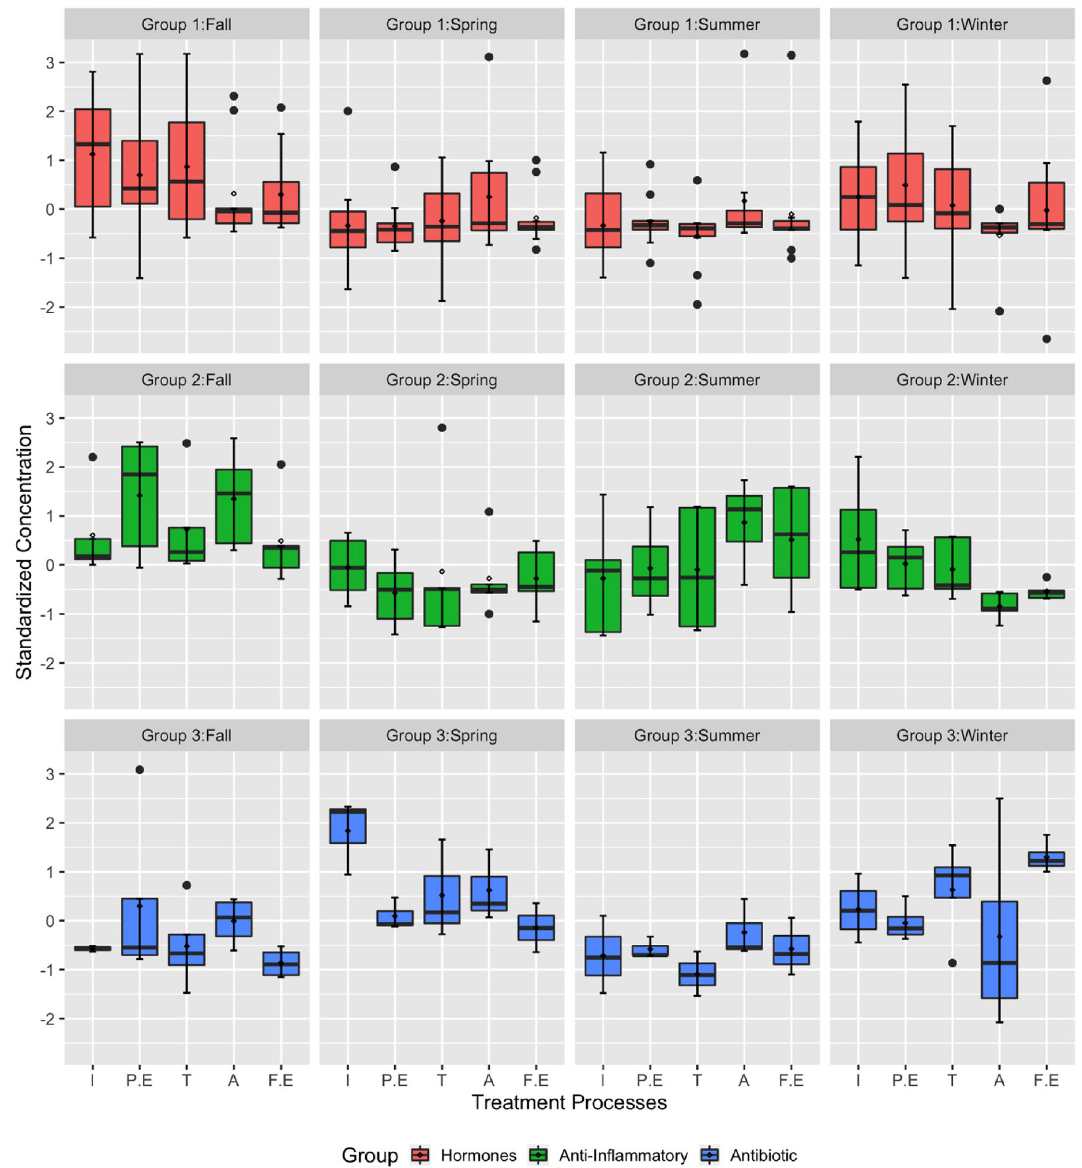
Fig. 3 The boxplots of the removal of compounds for groups in seasonal variation across treatment processes, with standard error